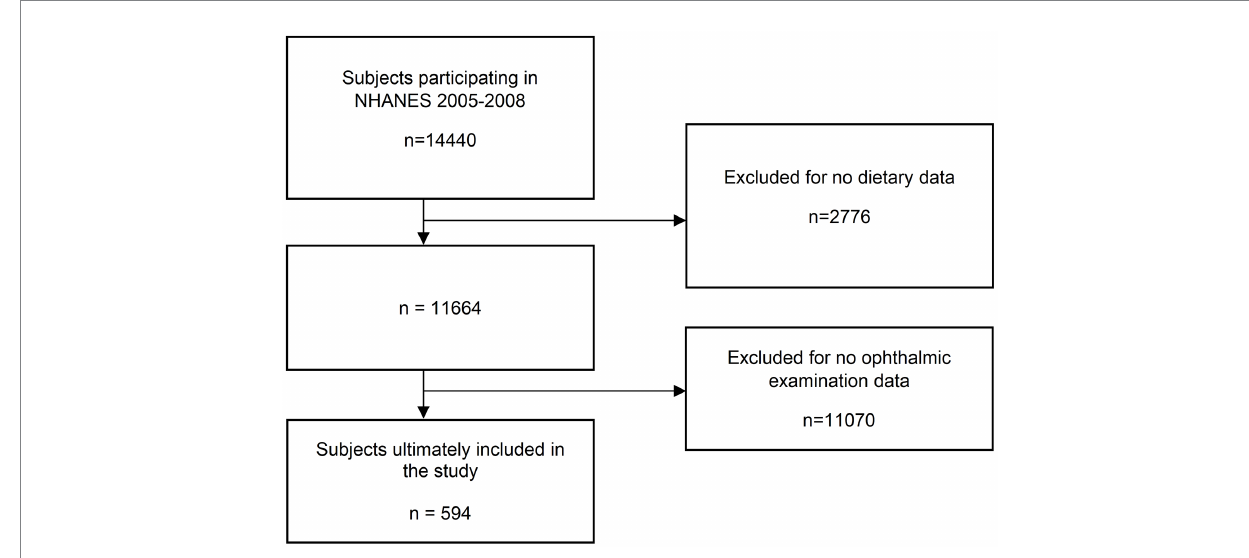
FIGURE 1 Screening process of the included